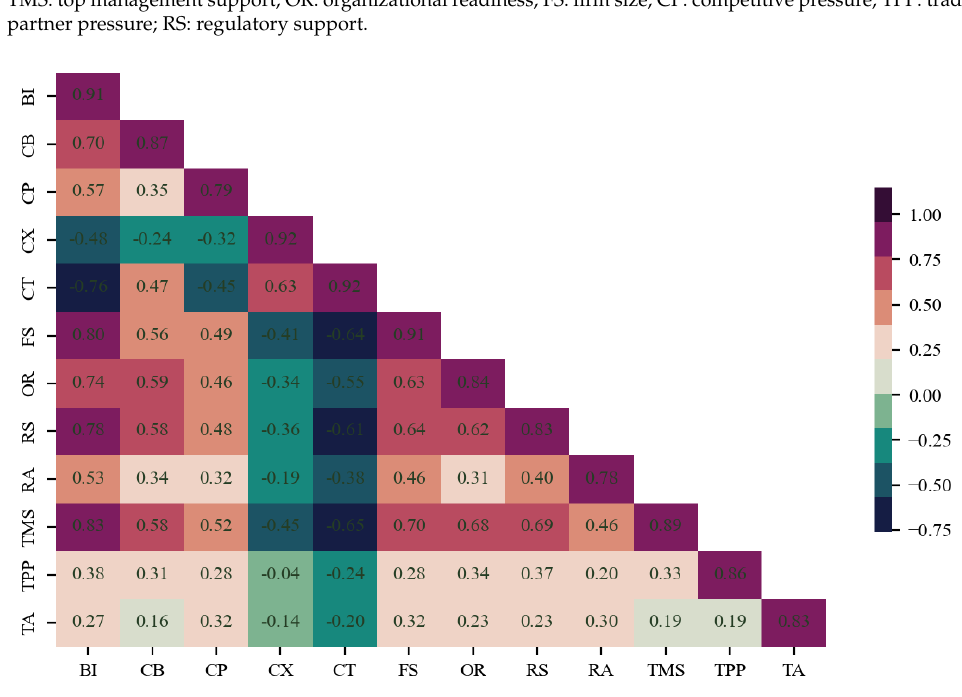
Figure 3. Measurement model. 5.1.2. Structural Model In this step, the proposed hypothesized relationships were examined using a bias- corrected bootstrap procedure with 5000 subsamples. As Table 3 and Figure 4 show, com- plexity, trialability , and trading partner pressure were non-significant factors at the 0.05 level. Among the remaining eight accepted relationships, compatibility, top management support, regulatory support, organizational readiness, relative advantage, firm size , and competitive